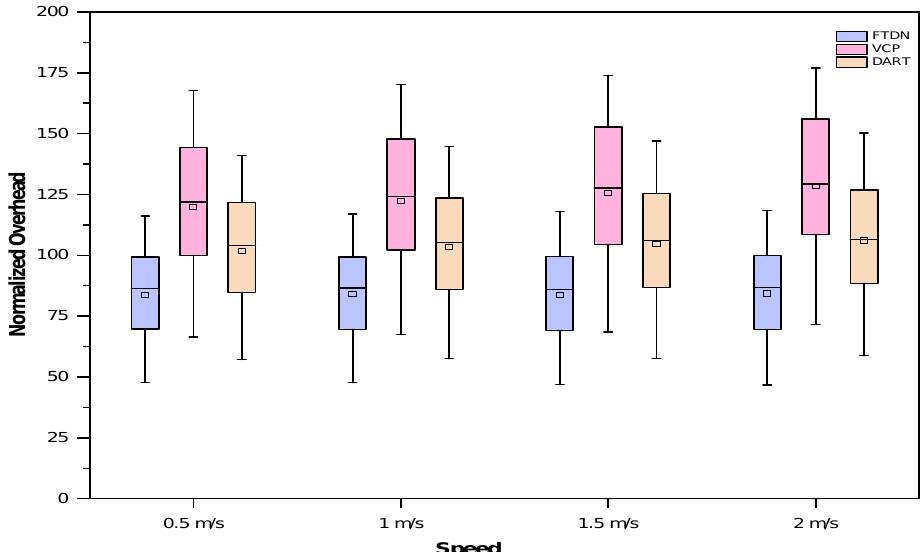
Figure 10. Normalized overhead results, as boxplots, against different node moving speeds with varying network